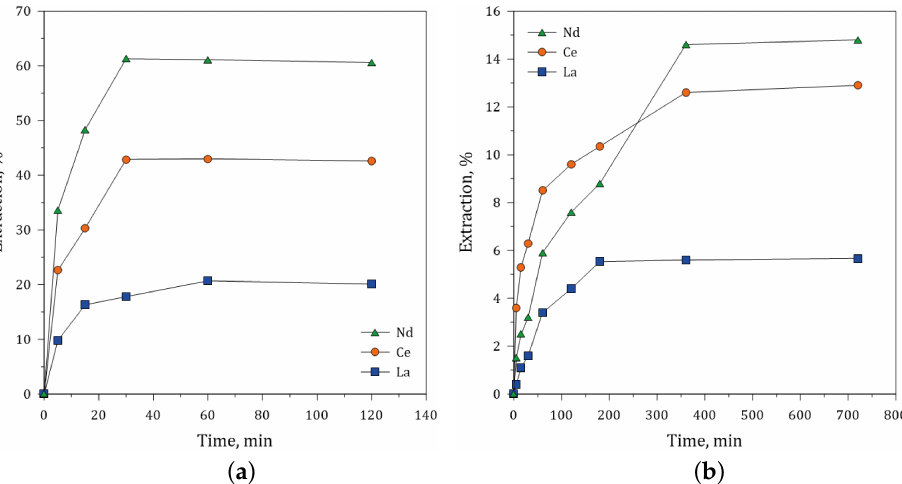
Figure 14. Effect of contact time on the extraction of La , Ce and Nd with: D 2 EHPA ( a ) and Cyanex 572 ( b